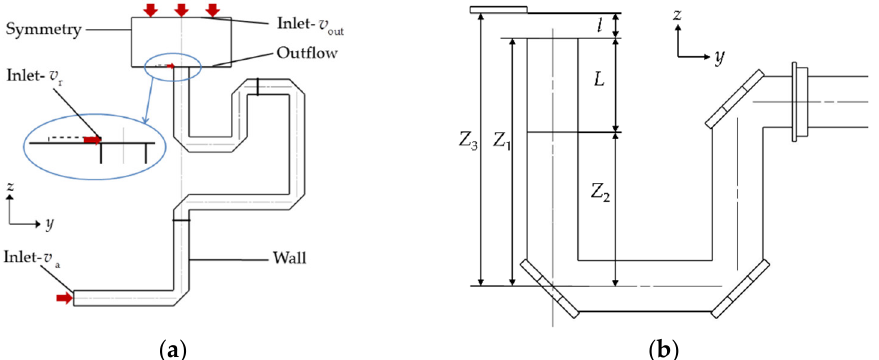
Figure 2. Fluid simulation model of the large-aperture channel. ( a ) The schematic diagram of the model boundary conditions; ( b ) the monitoring distance and the radial wind distance location diagram.